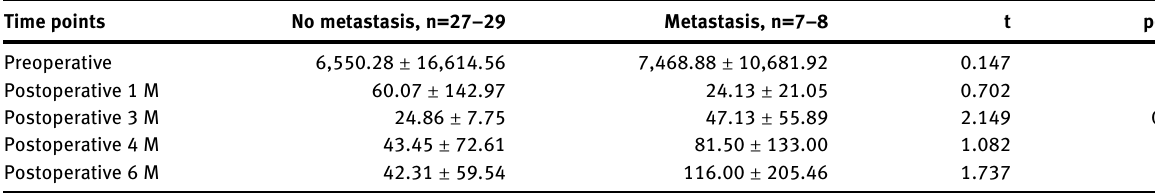
Table  : Association between PIVKA-II levels and postoperative metastasis. Time points